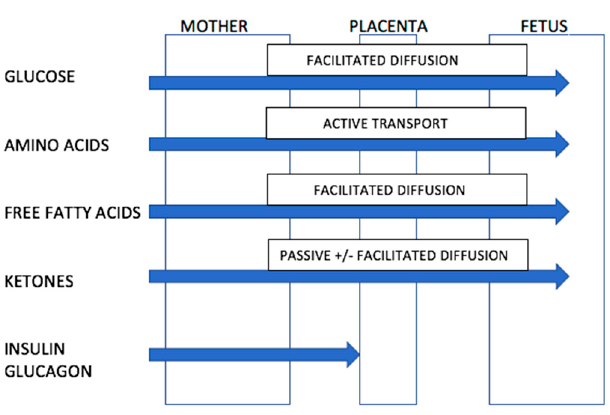
Figure 1. Ability of nutrients and ketones to transverse the placenta. Source: Adapted from Rudolf, M.C.; Sherwin, R.S. [67]. (Nb. Transport of free fatty acids across the placenta remains controversial but may occur via facilitated diffusion. The placenta may protect the fetus from excessive fatty acid exposure through esterification of free fatty acids to triglycerides).